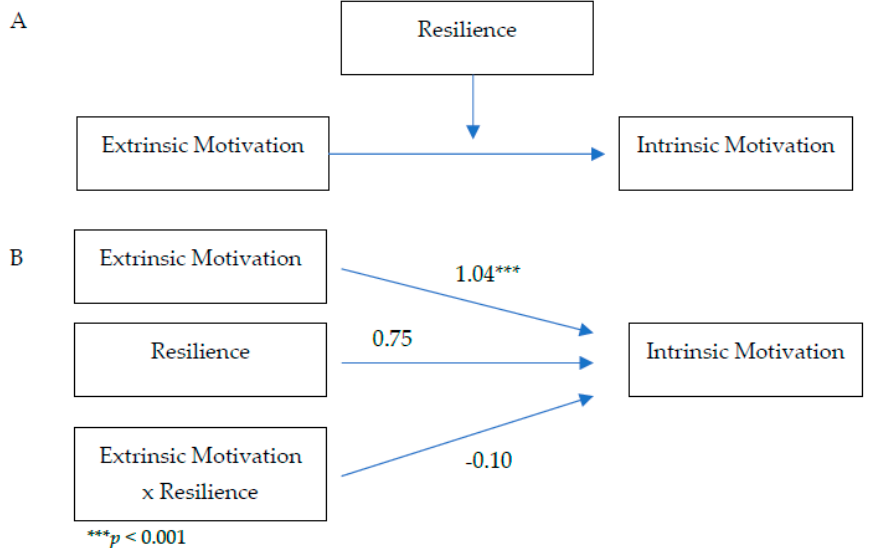
Figure 2. Moderation of resilience on the pathway from extrinsic motivation to intrinsic motivation: conceptual diagram (panel A) and statistical diagram (panel B).